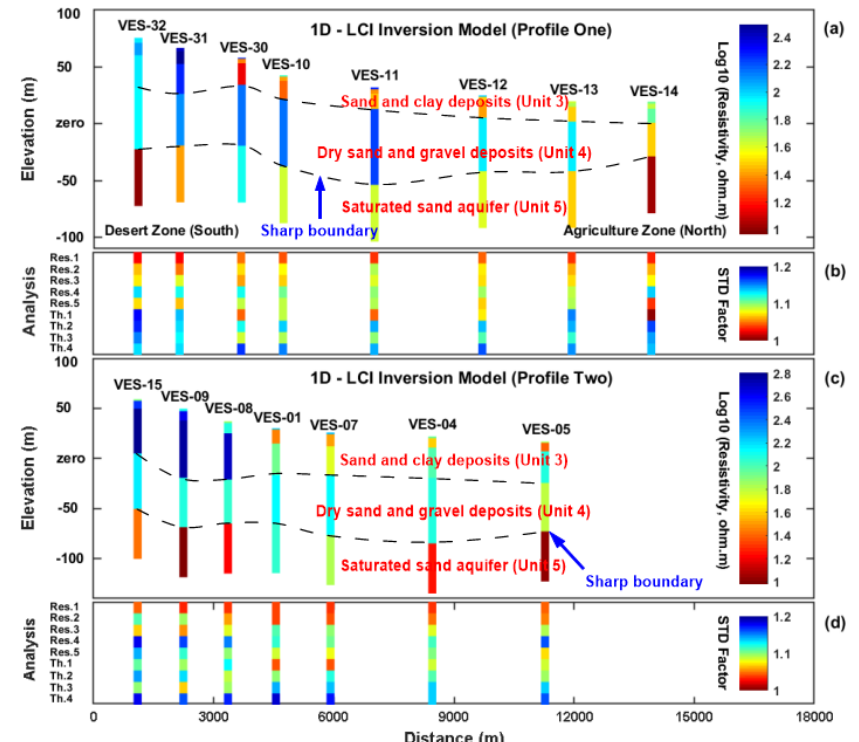
Figure 8. ( a , c ) Inversion result from synchronized 1D–LCI inversion model using five layers, constructed from DC VES soundings along profiles one and two, respectively. ( b , d ) Detailed plot of the solution analysis of model parameters, calculated from final model of 1D– LCI inversion (resistivities; Res.1–Res.5 and thicknesses; Th.1–Th.4) along profiles one and two, respectively. The color-coding of the analysis ranging from red (well resolved parameter, STD factor = 1) to blue (moderately resolved parameter, STD Factor = 1.2).